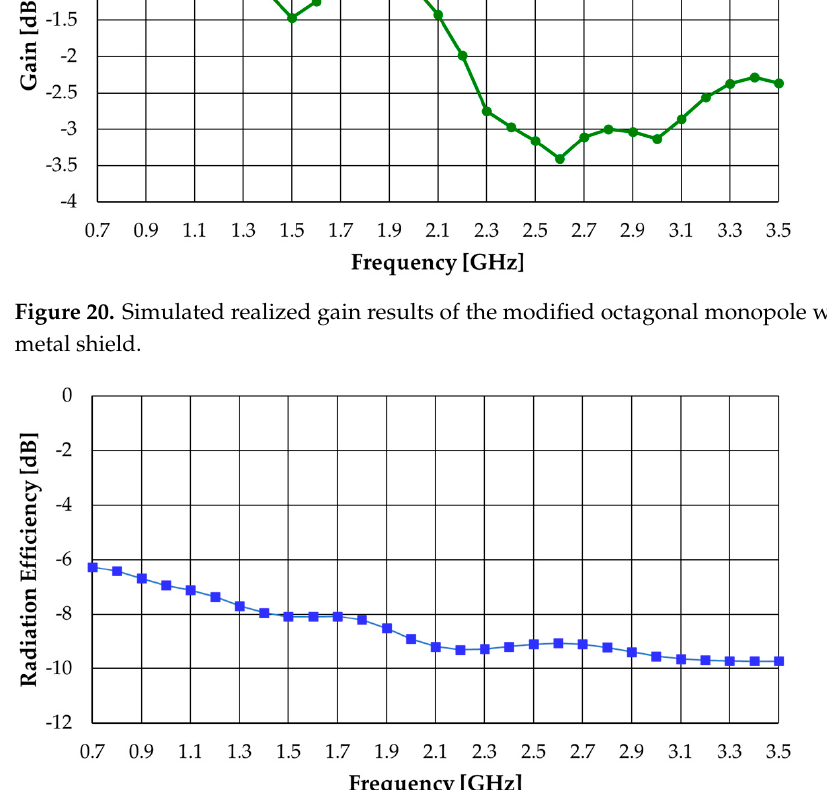
Figure 20. Simulated realized gain results of the modified octagonal monopole with absorber and metal shield.